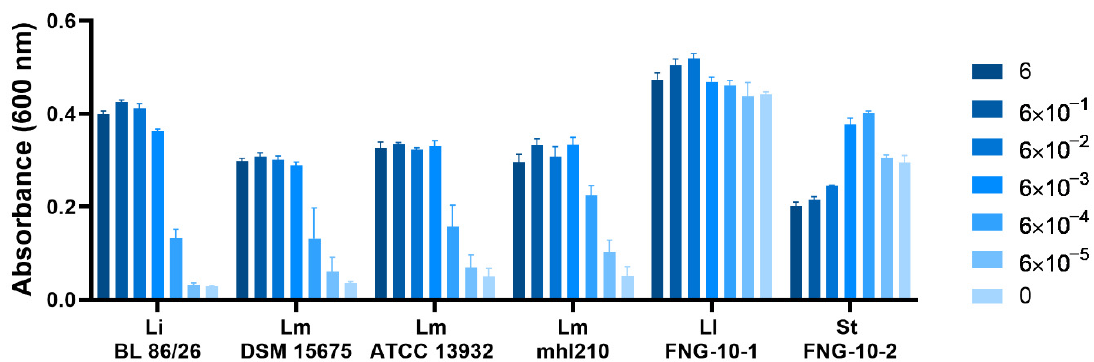
Figure 4. The effect of Mn on growth of Listeria spp., L. lactis FNG-10-1 or S. thermophilus FNG-10-2 in CDM. Depicted are the corrected and averaged OD 600 values of 20-h-old cultures grown in Mn-free CDM supplemented with the indicated MnCl 2 concentration (in mg/L). All cultures were grown in six-fold as standing 200-µL cultures at 30 °C in 96-well plates covered with a transparent seal. Li = L. innocua , Lm = L. monocytogenes , Ll = L. lactis , St = S. thermophilus . Growth curves and doubling times are provided in Supplementary Materials Figure S2.